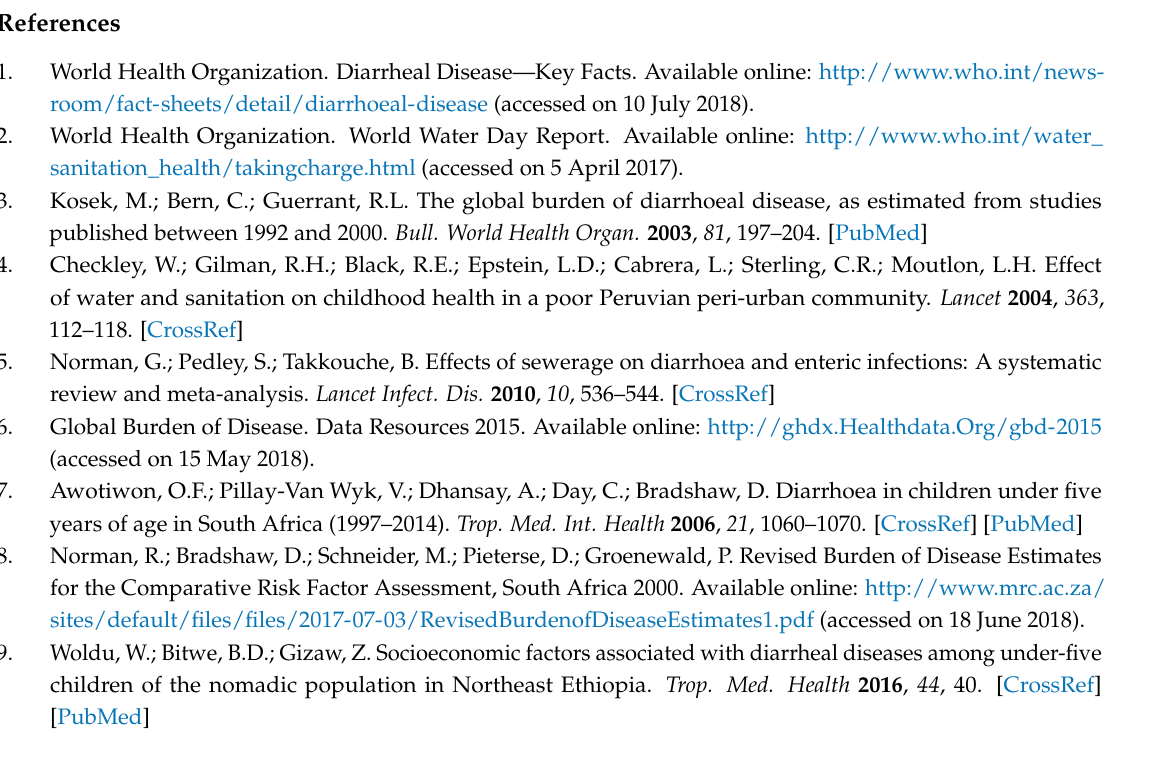
Figure S1: Full study